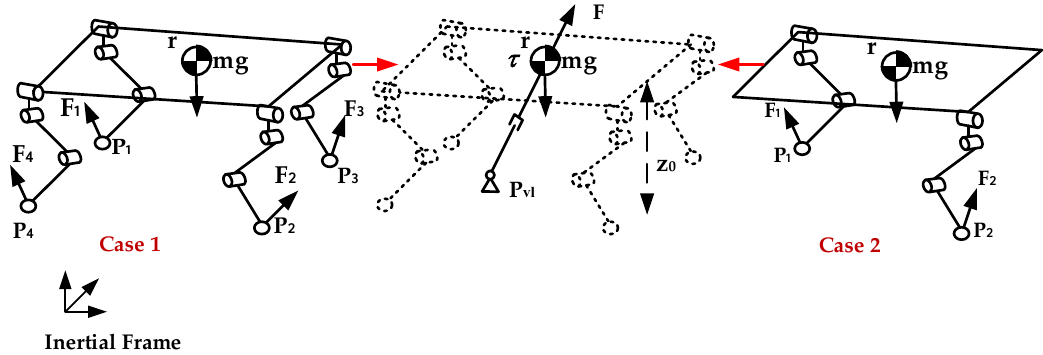
Figure 4. The simplification of the quadruped robot to the Linear Inverted Pendulum